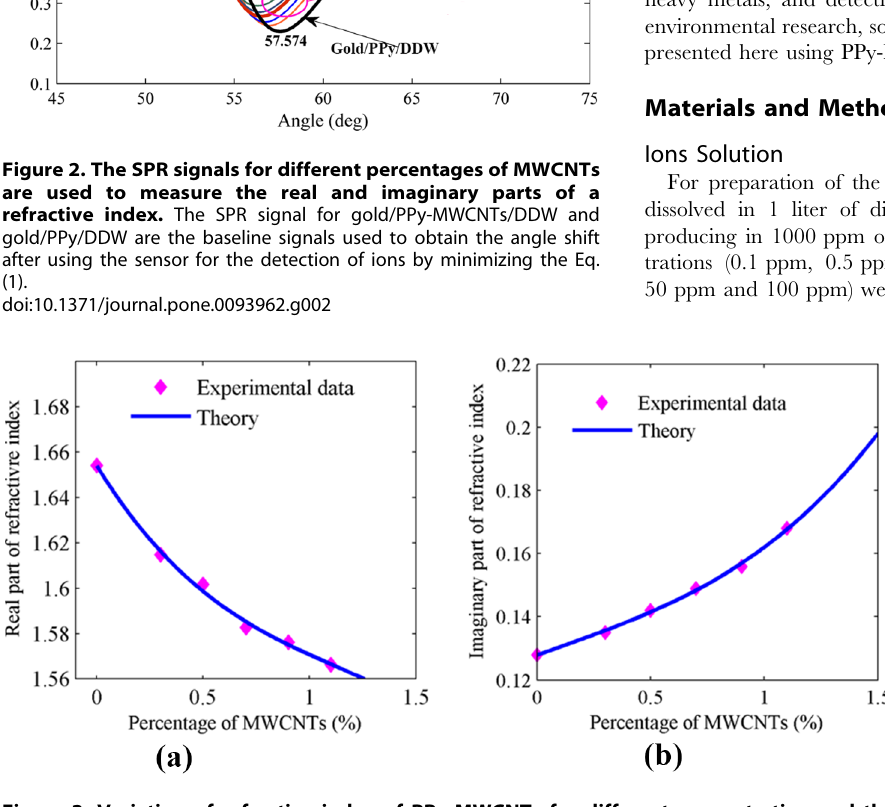
Figure 3. Variation of refractive index of PPy-MWCNTs for different concentration and the same thickness; a) real part of the refractive index; b) imaginary part of the refractive